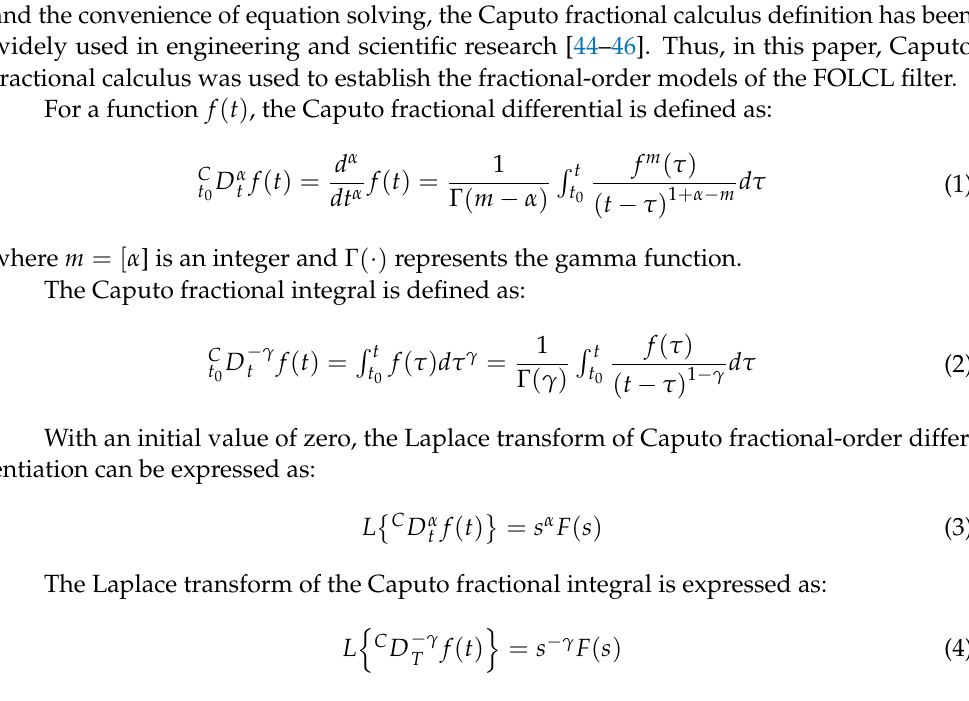
− Figure 2. Block diagram of single-phase FOLCL filter. In Figure 2, 𝑍𝑍 𝐿𝐿1 ( 𝑠𝑠 ), 𝑍𝑍 𝑐𝑐 ( 𝑠𝑠 ), and 𝑍𝑍 𝐿𝐿2 ( 𝑠𝑠 ) are the impedances of 𝐿𝐿 1 , 𝐶𝐶 , and 𝐿𝐿 2 , respec- tively. Their expressions are: 𝑍𝑍 𝐿𝐿1 ( 𝑠𝑠 ) = 𝐿𝐿 1 𝑠𝑠 𝛼𝛼 1 , 𝑍𝑍 𝑐𝑐 ( 𝑠𝑠 ) = 1 𝐶𝐶𝑠𝑠 𝛽𝛽 , 𝑍𝑍 𝐿𝐿2 ( 𝑠𝑠 ) = 𝐿𝐿 2 𝑠𝑠 𝛼𝛼 2